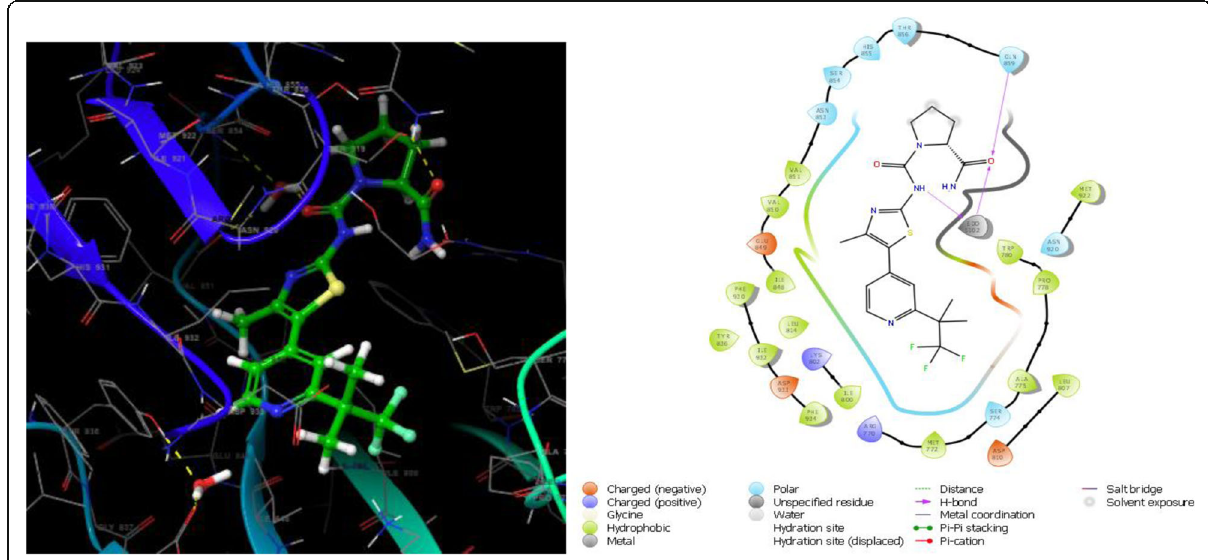
Fig. 3 Interaction of Alpelisib with PIK3C α , both 3D and 2D diagrams, is given below with yellow dotted line represents